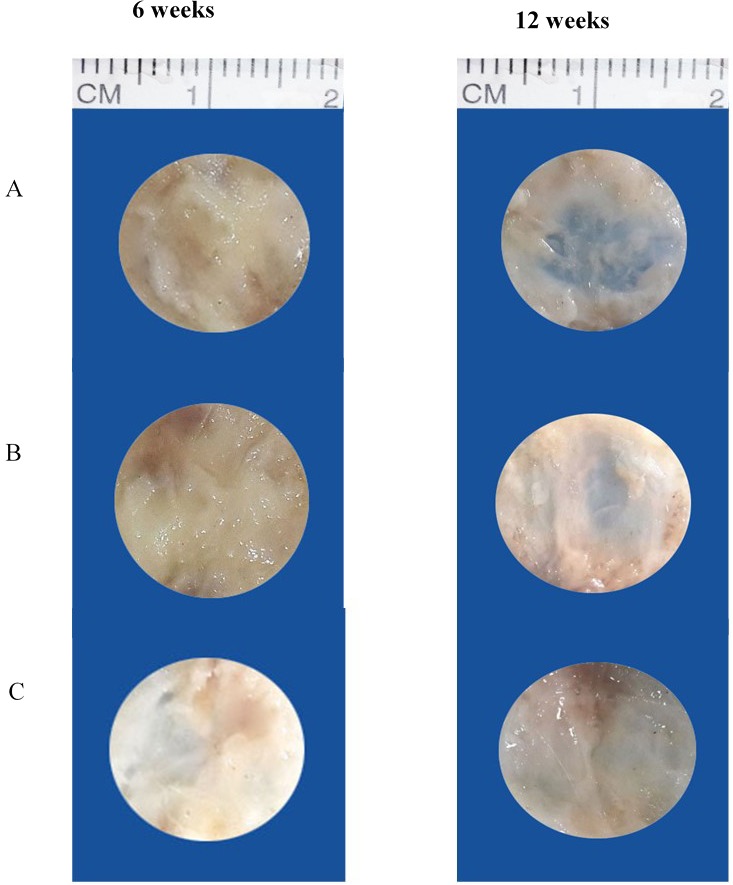
Gross appearance of surgical defects at 6 and 12 weeks.(A) Group I (control), (B) group II (chitosan gel), and (C) group III (OPG-chitosan gel).